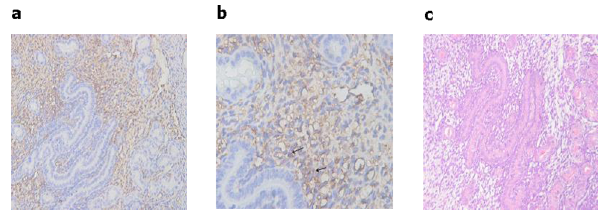
Figure 1. Identification of YS-HSCs. (a, b, and c) Immunohisto- chemistry staining of CD41 in E9 murine embyo yolk sacs. The arrows refer to cells expressing CD41 in E9 murine embryo yolk sacs. Magnifications: (a) 200 6 ; (b) 400 6 ; and (c) A representative section of H & E staining of the E9 murine embryo yolk sacs (magnification of 200 6